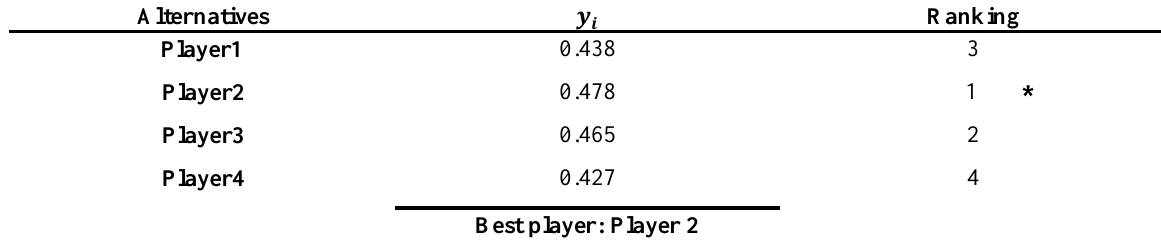
Table.8 . ranking the alternatives Alternatives 𝒚 Ranking 𝒊 Player1 0.438 3 Player2 0.478 1 * Player3 0.465 2 Player4 0.427 4 Best player: Player